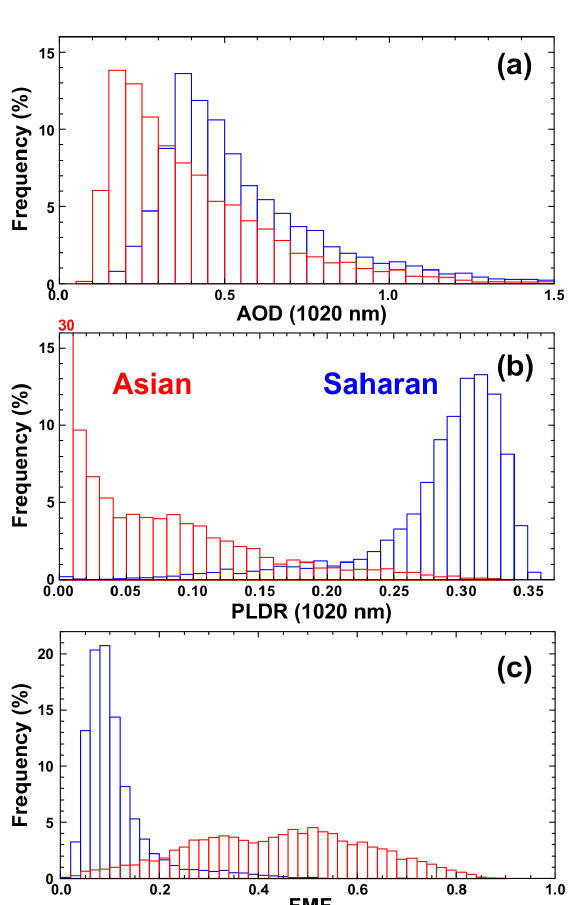
Figure 2. Histograms of the 1020nm AOD (a) , 1020nm PLDR (b) , and FMF (c) for the considered AERONET stations affected by Sa- haran (blue) and Asian dust (red). The coloured number provides the value for the bar that exceeds the scale. Details on the consid- ered AERONET stations and mean values are provided in Table 2.